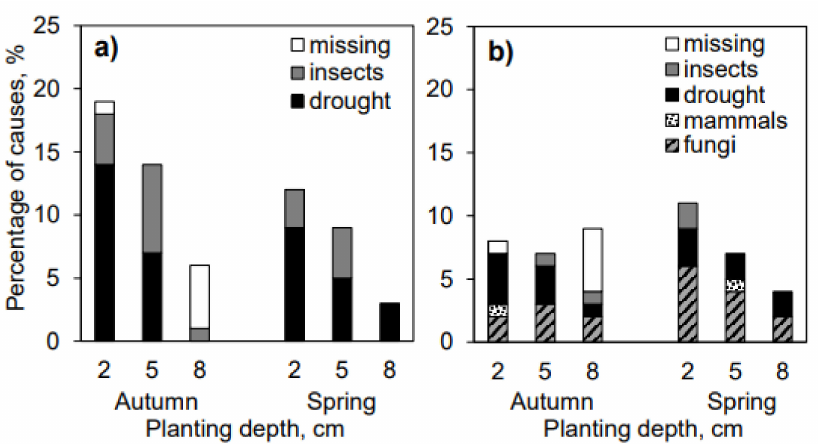
Figure 4. Percentage of causes of damage and missing seedlings in autumn (A) and spring (S) planted Scots pine seedlings ( a ) after the first (year 2019) and ( b ) second (year 2020) growing seasons at different planting